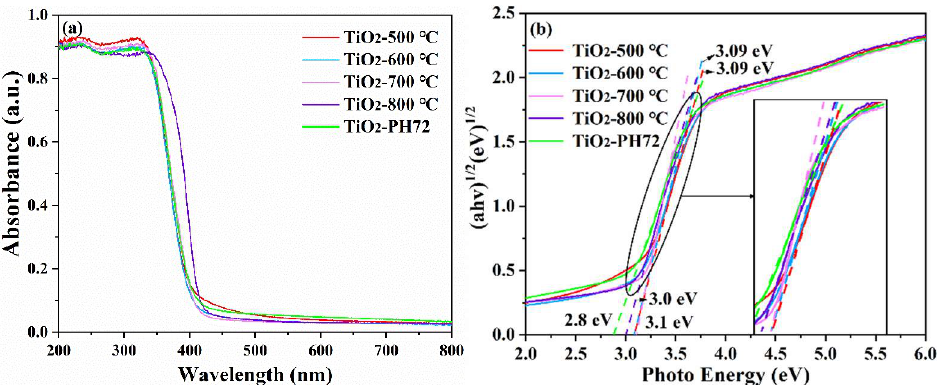
Figure 9. UV-vis diagram ( a ) and Tauc plots ( b ) of the fibers obtained after different calcination temperatures and plasma treatments.